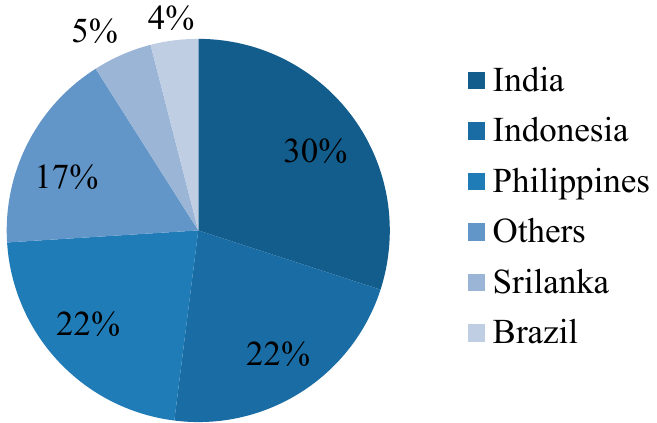
Figure 1. The production of coconut nuts worldwide.